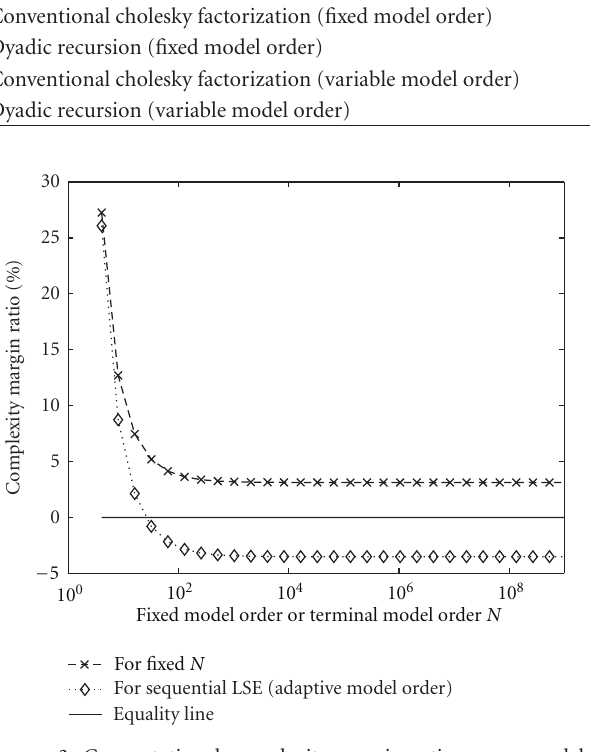
Figure 5: Various least mean-squared errors σ 2 ( N ) − C (cid:2) R − 1 ( N )) / ( C (cid:2) R − 1 ( N ))%, noise ratio (the threshold for our variable model scheme is τ J = new Chol Chol 1 / 30). ( N ) − C (cid:2) R − 1 ( N )) / ( C (cid:2) R − 1 ( N ))%, new,seq Chol,seq Chol,seq